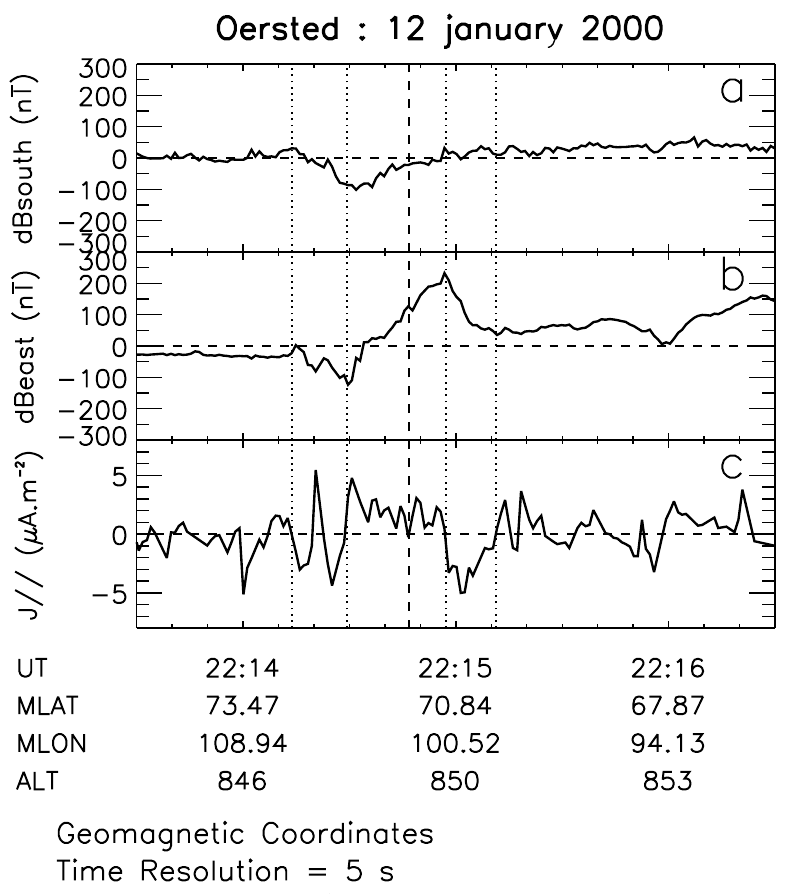
Fig. 6. Magnetic field and field- aligned currents measured by Ørsted. (a) North-south component. (b) East- west component. (c) Field-aligned cur- rents intensity averaged over 5s. Dotted lines delineate the three parallel current sheets and the dashed line indicates the velocity shear.